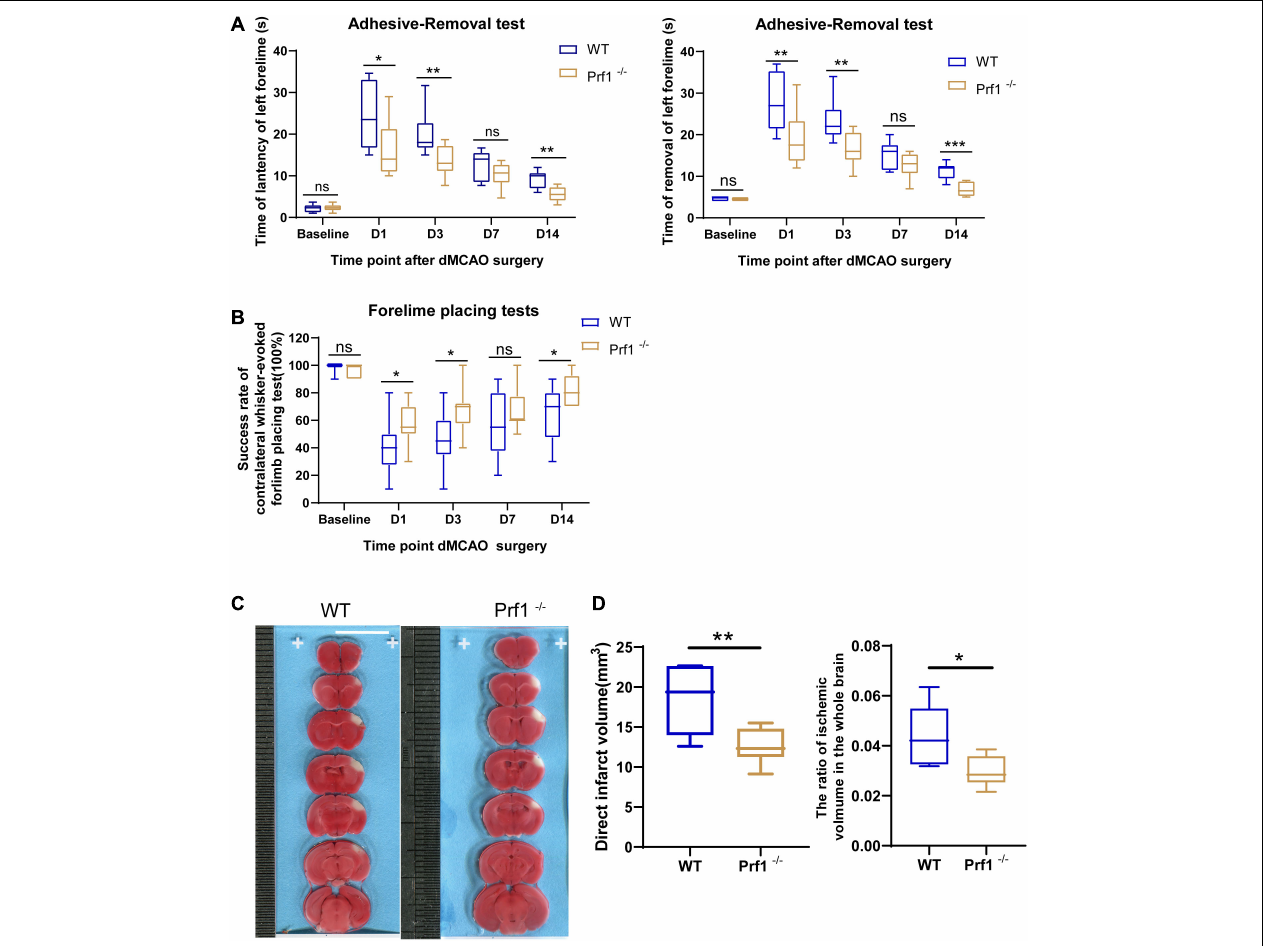
FIGURE 3 | Perforin + CD45 + cells significantly worsen outcomes after ischemic stroke. (A) The adhesive removal test was performed to examine the effect of Prf1 - / - on functional recovery (latency and removal time) before surgery and 12 h, 1, 3, 7, and 14 days after focal cerebral ischemia. n = (6–10) animals in each group; Prf1 - / - mice vs. WT mice at each time point. * P < 0.05, ** P < 0.01, *** P < 0.001. (B) There was a significant difference in performance on the whisker test between Prf1 - / - and WT mice at the time points mentioned before. (C) TTC-stained sections from adult WT and Prf1 - / - mice 3 days after dMCAO. Scale bars = 10